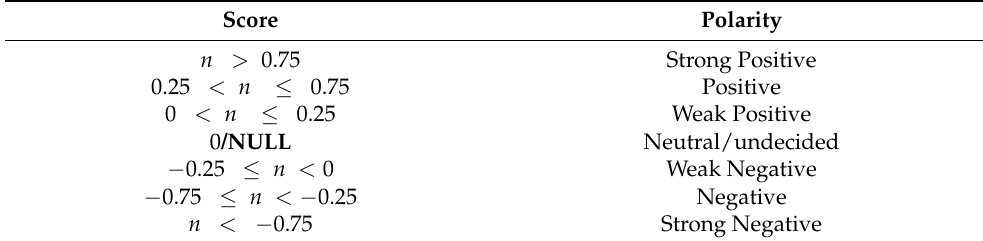
Table 2. The seven polarity levels